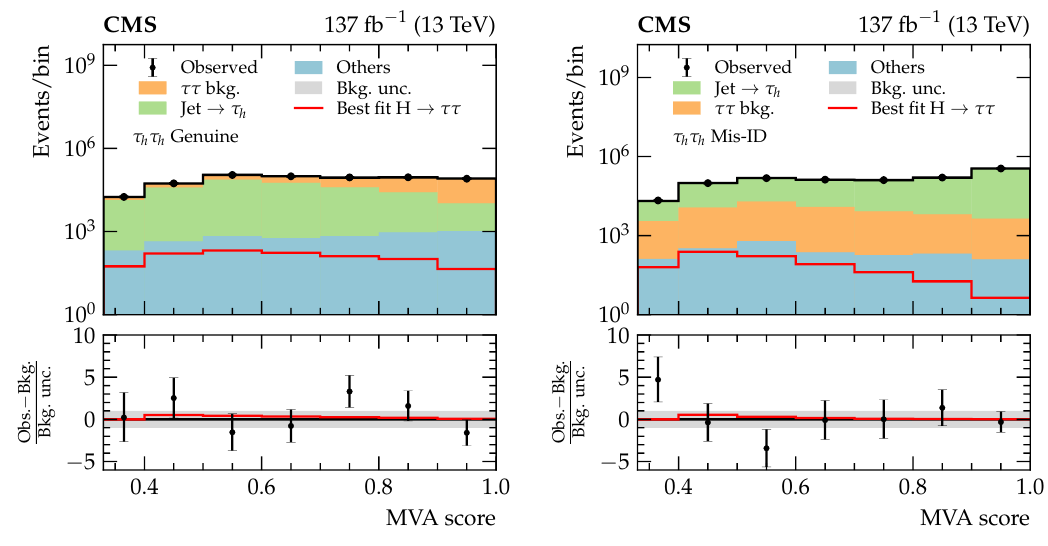
Figure 7 . The post-fit MVA score distributions for the Genuine (left) and Mis-ID categories (right) in the t channel. The distributions are inclusive in t decay mode. The best fit signal h t h h distributions are overlaid, where the signal cross sections are set to the values obtained from the fit to data, which are given in section 12.1. In the lower panels, the data minus the background template divided by the uncertainty in the background template is displayed, as well as the signal distribution divided by the uncertainty in the background template. The uncertainty band accounts for all sources of systematic uncertainty in the background prediction, after the fit to